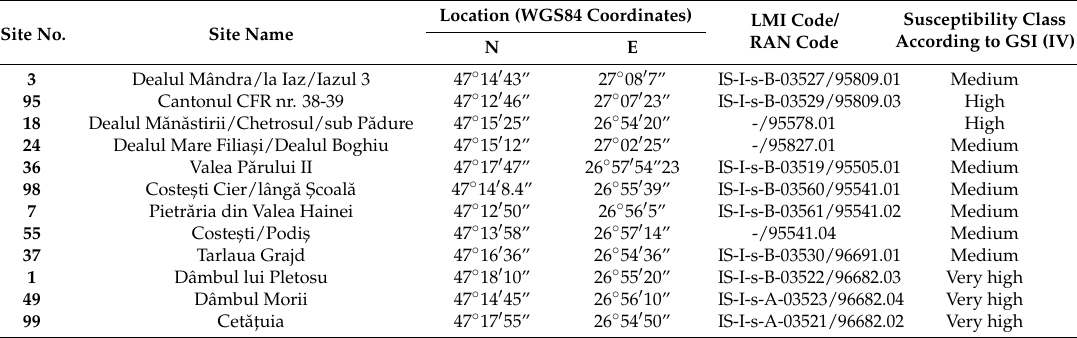
Table 2. Neolithic sites listed in the List of Historical Monuments (LMI) and National Archaeological Registry (RAN). GSI—gully susceptibility index; IV—information value.